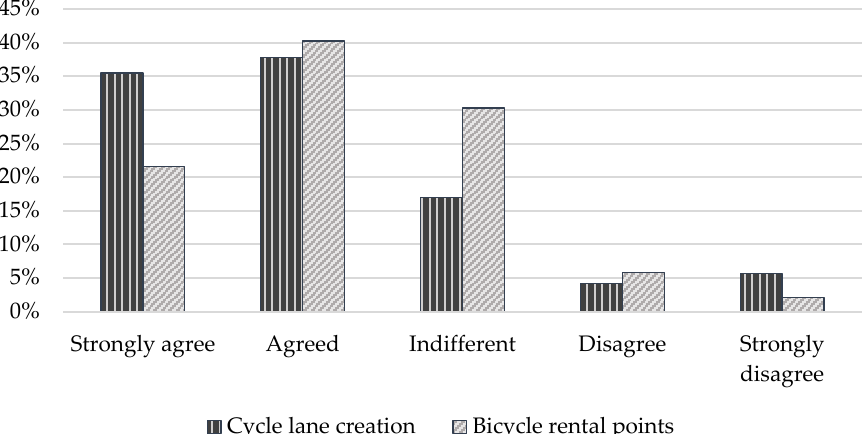
Figure 14. Assessment of cycling mobility proposals.